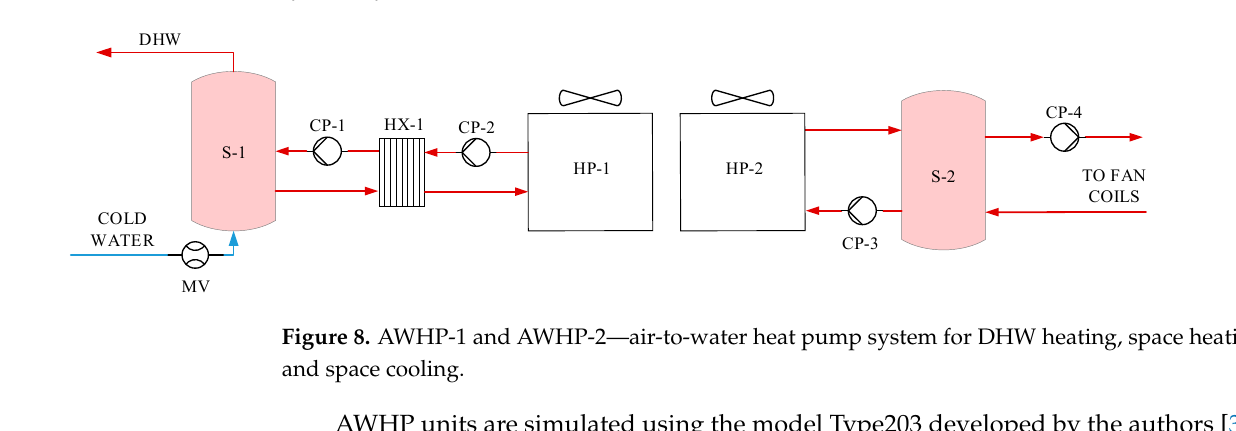
Figure 7. SL-FO-ACH-2/S-NG-ACH-2—solar space and DHW heating and absorption space cooling system layout.